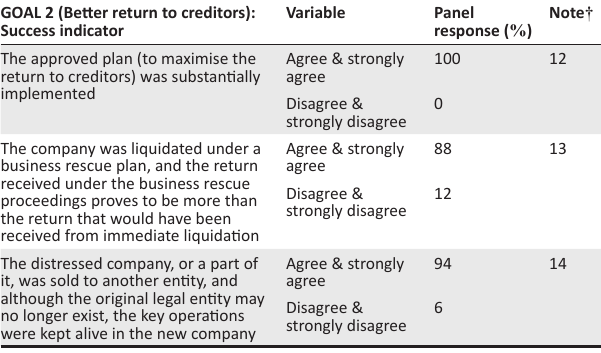
TABLE 5: Business rescue success criteria for Goal 2 (better return to creditors).